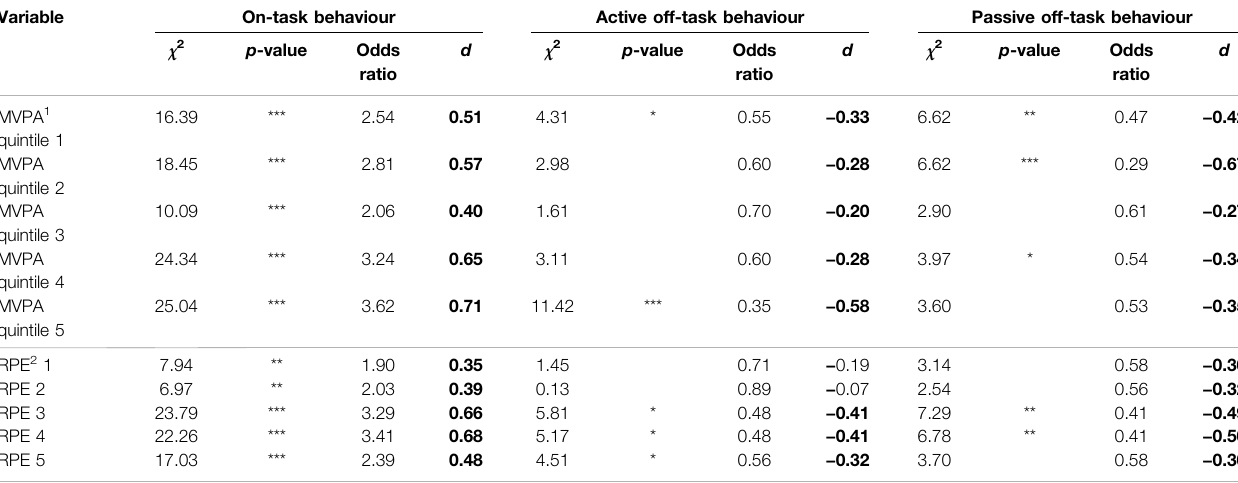
TABLE 5 | Response of task behaviour to objective and subjective PA in the least on-task sub-sample. Variable